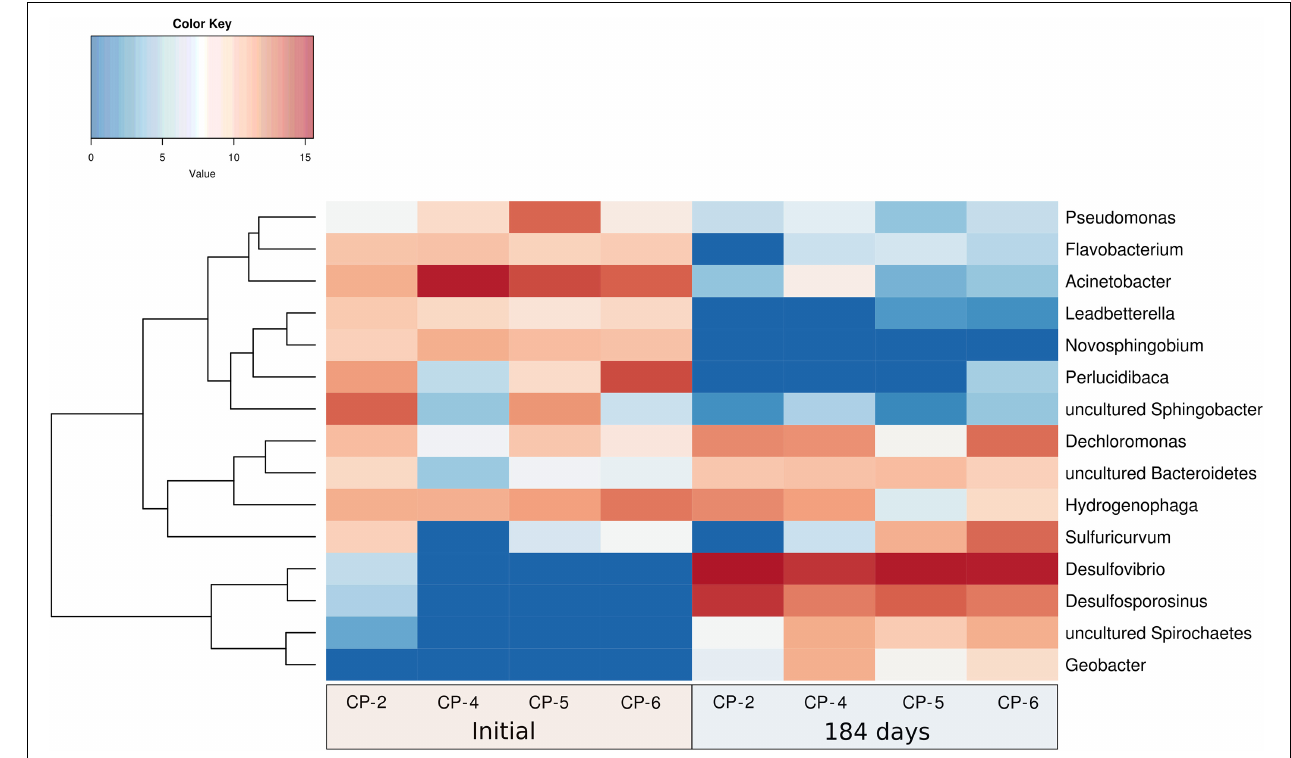
uncultured Sphingobacteria (13%), Hydrogenophaga